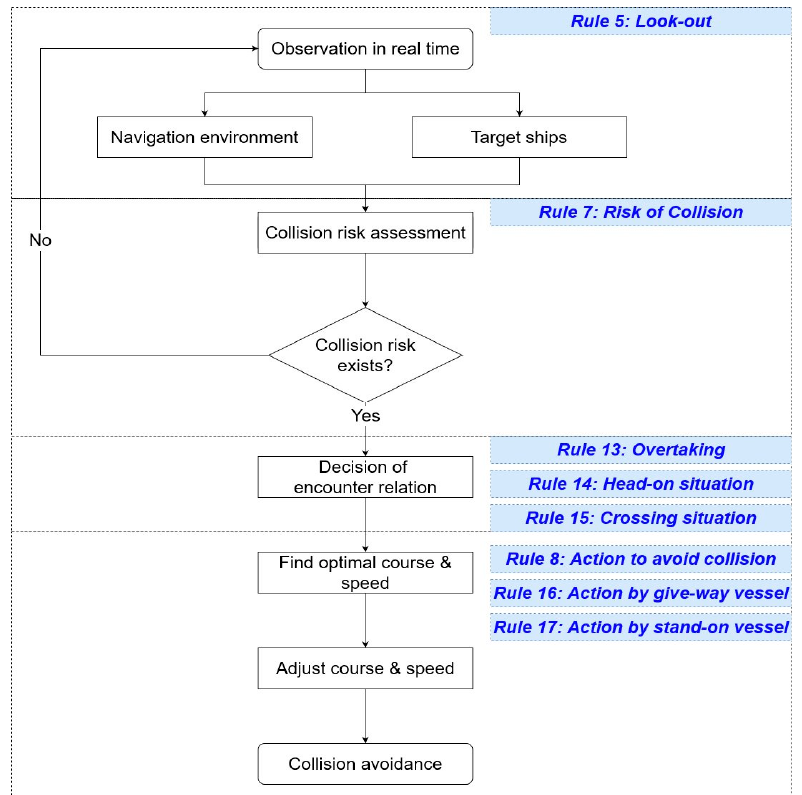
Figure 1. Procedure for collision avoidance in accordance with the International Regulations for Preventing Collision at the Sea (COLREGs).